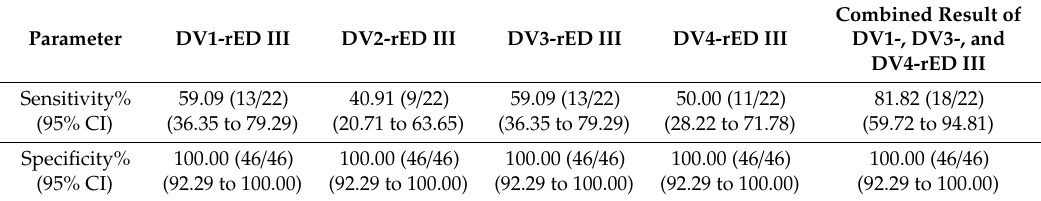
Table 5. Combined result of DV-rED III-ELISA sensitivity and